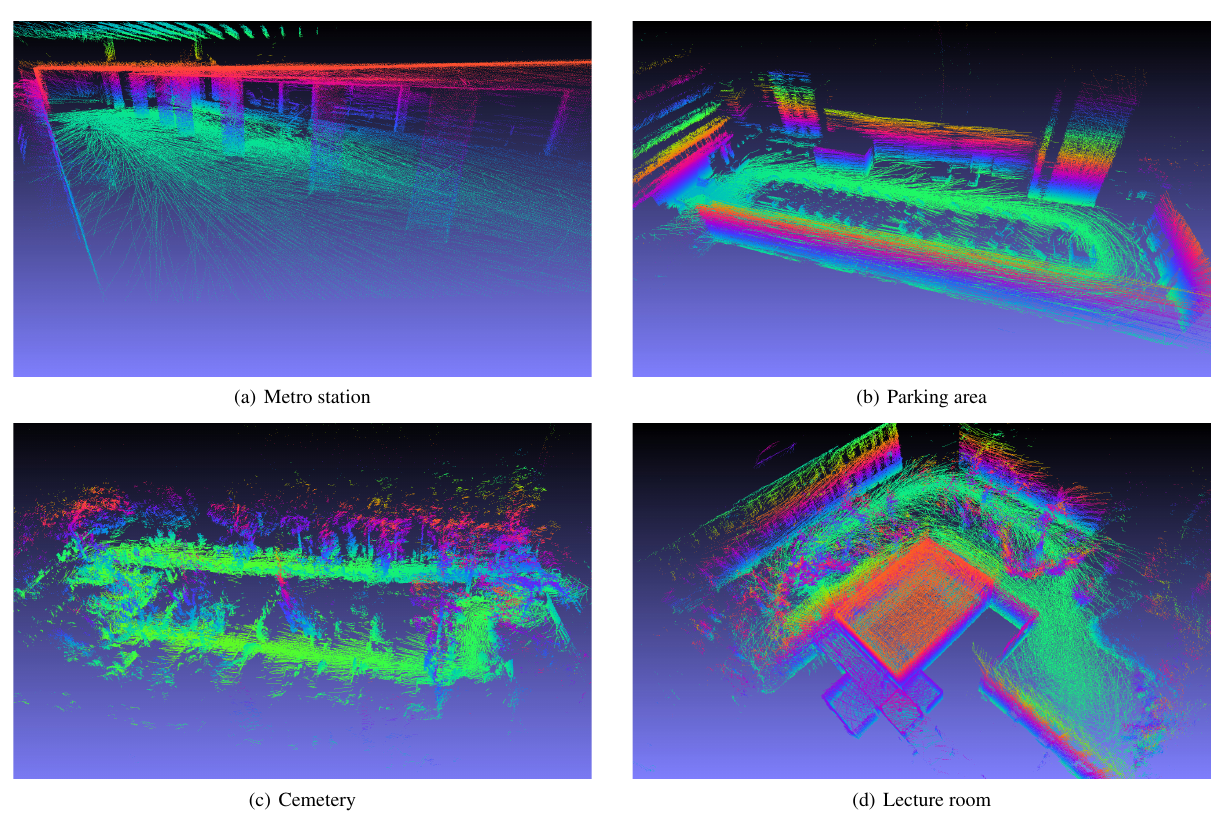
Figure 5. Maps generated using the discussed SLAM approach. Point clouds are color coded by elevation to generate 3D perception. generated using the extension of the previously discussed SLAM approach.